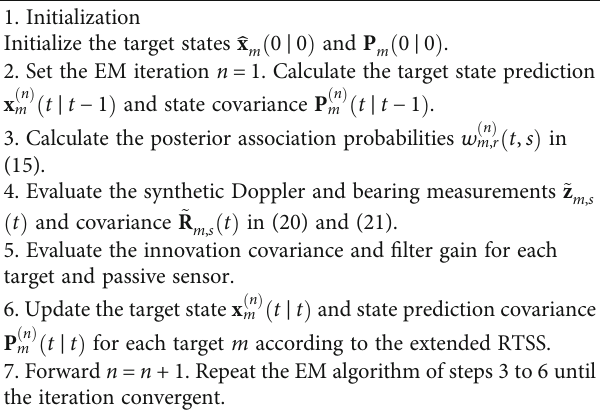
Table 1: Batch recursive multiple-sensor